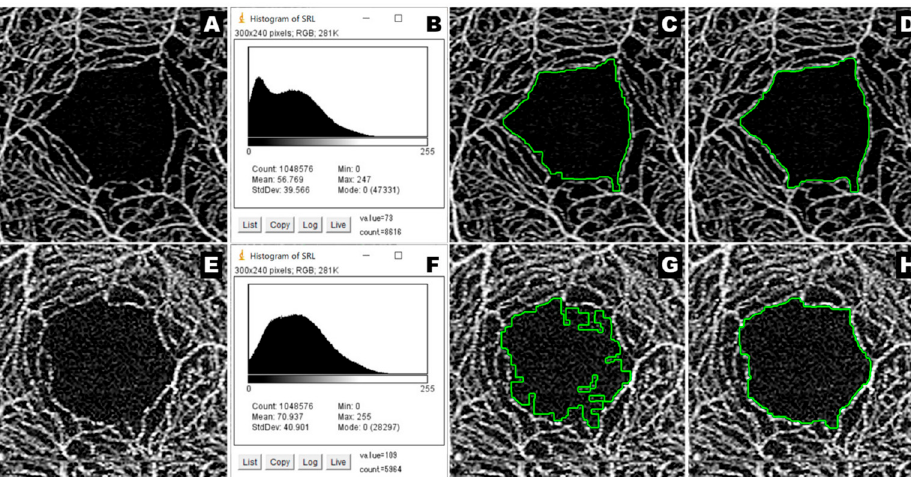
Figure 1. Effects of the change in KSM settings. A typical captured image ( A ) and its histogram ( B ). High-brightness images ( E ) and its histogram ( F ). Represent images extracted with the previously- reported settings ( C , G ), Represent images extracted after the settings were changed ( D , H ). PLEX ® Elite 9000 can acquire images with high-brightness ( E ). The histogram ( F ) of an image with high- brightness is different from the histogram ( B ) of a typical captured image ( A ). The higher the brightness of the image, the stronger the influence of noise during region extraction, thus, resulting in poorer extraction ( G ). When noise processing is added, extraction can be improved, as ( H ) is better than ( G ). Moreover, noise processing can enhance the extraction quality for typical captured images, as ( D ) is better than ( C ). KSM: Kanno Saitama Macro.